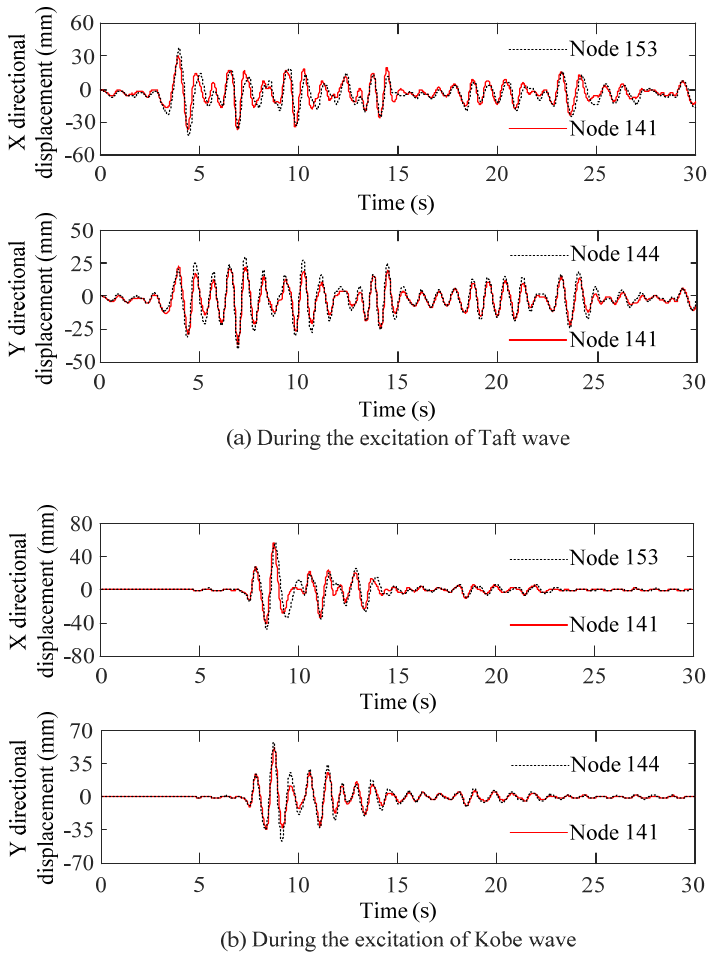
Figure 14. Contrasts of the horizontal displacement response at the top node of the structure with MRDs.